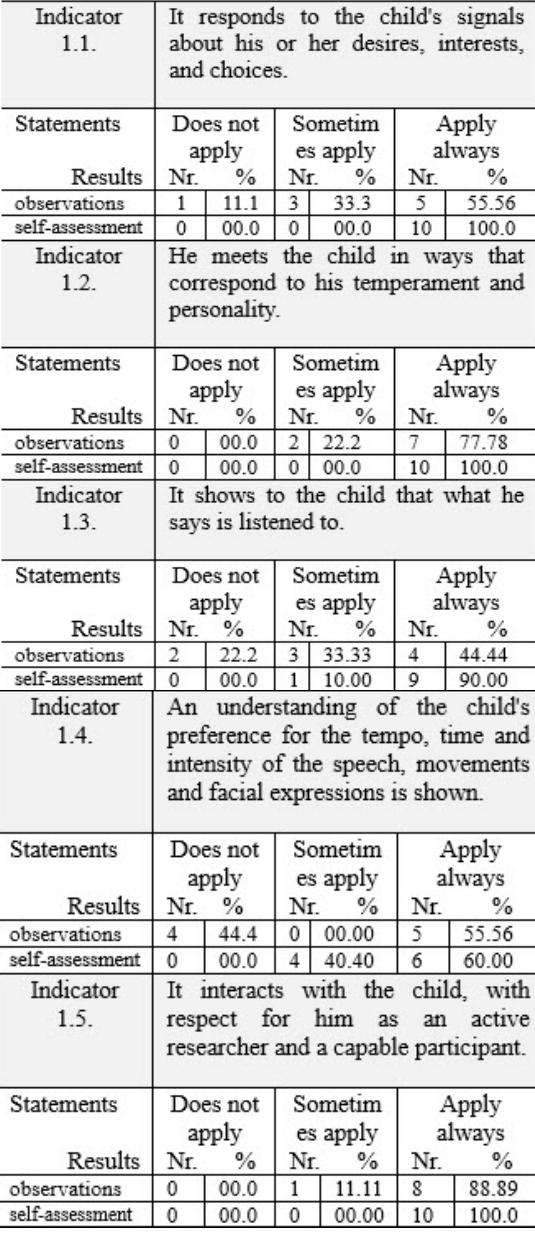
Table 1. Principle 1: Relationship with each child recognizes and values its unique - ness, competencies, personal style of commu - nication, preferences and